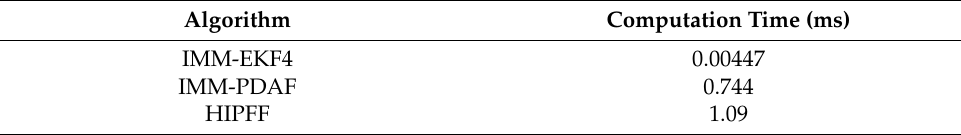
Table 2. Computation